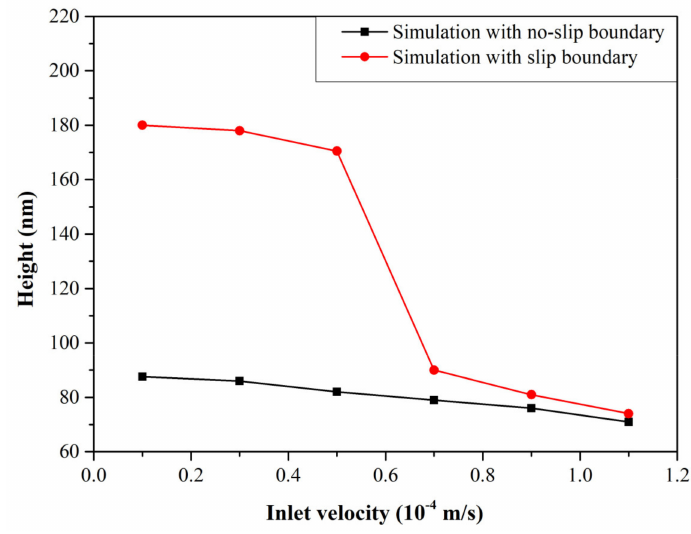
Figure 9. Effect of inlet velocity on the filling height of moth-eye nanostructure.